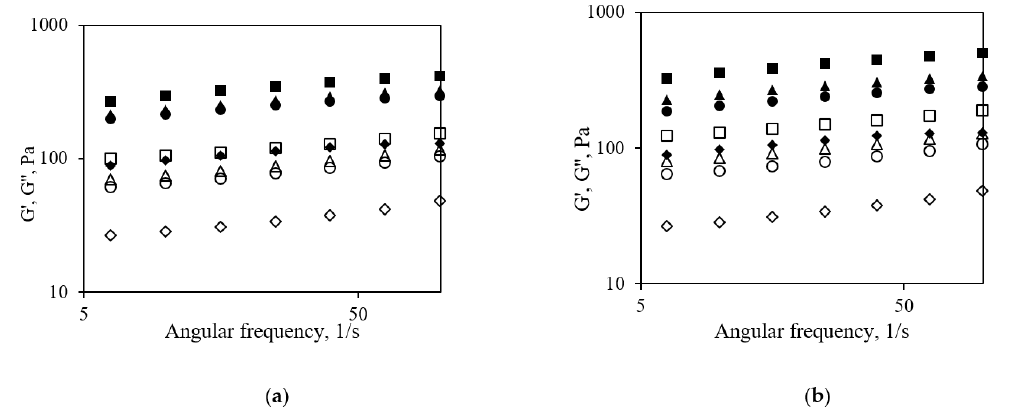
Figure 2 . Frequency sweep tests of yogurt made by adding different amounts of CP after ( a )